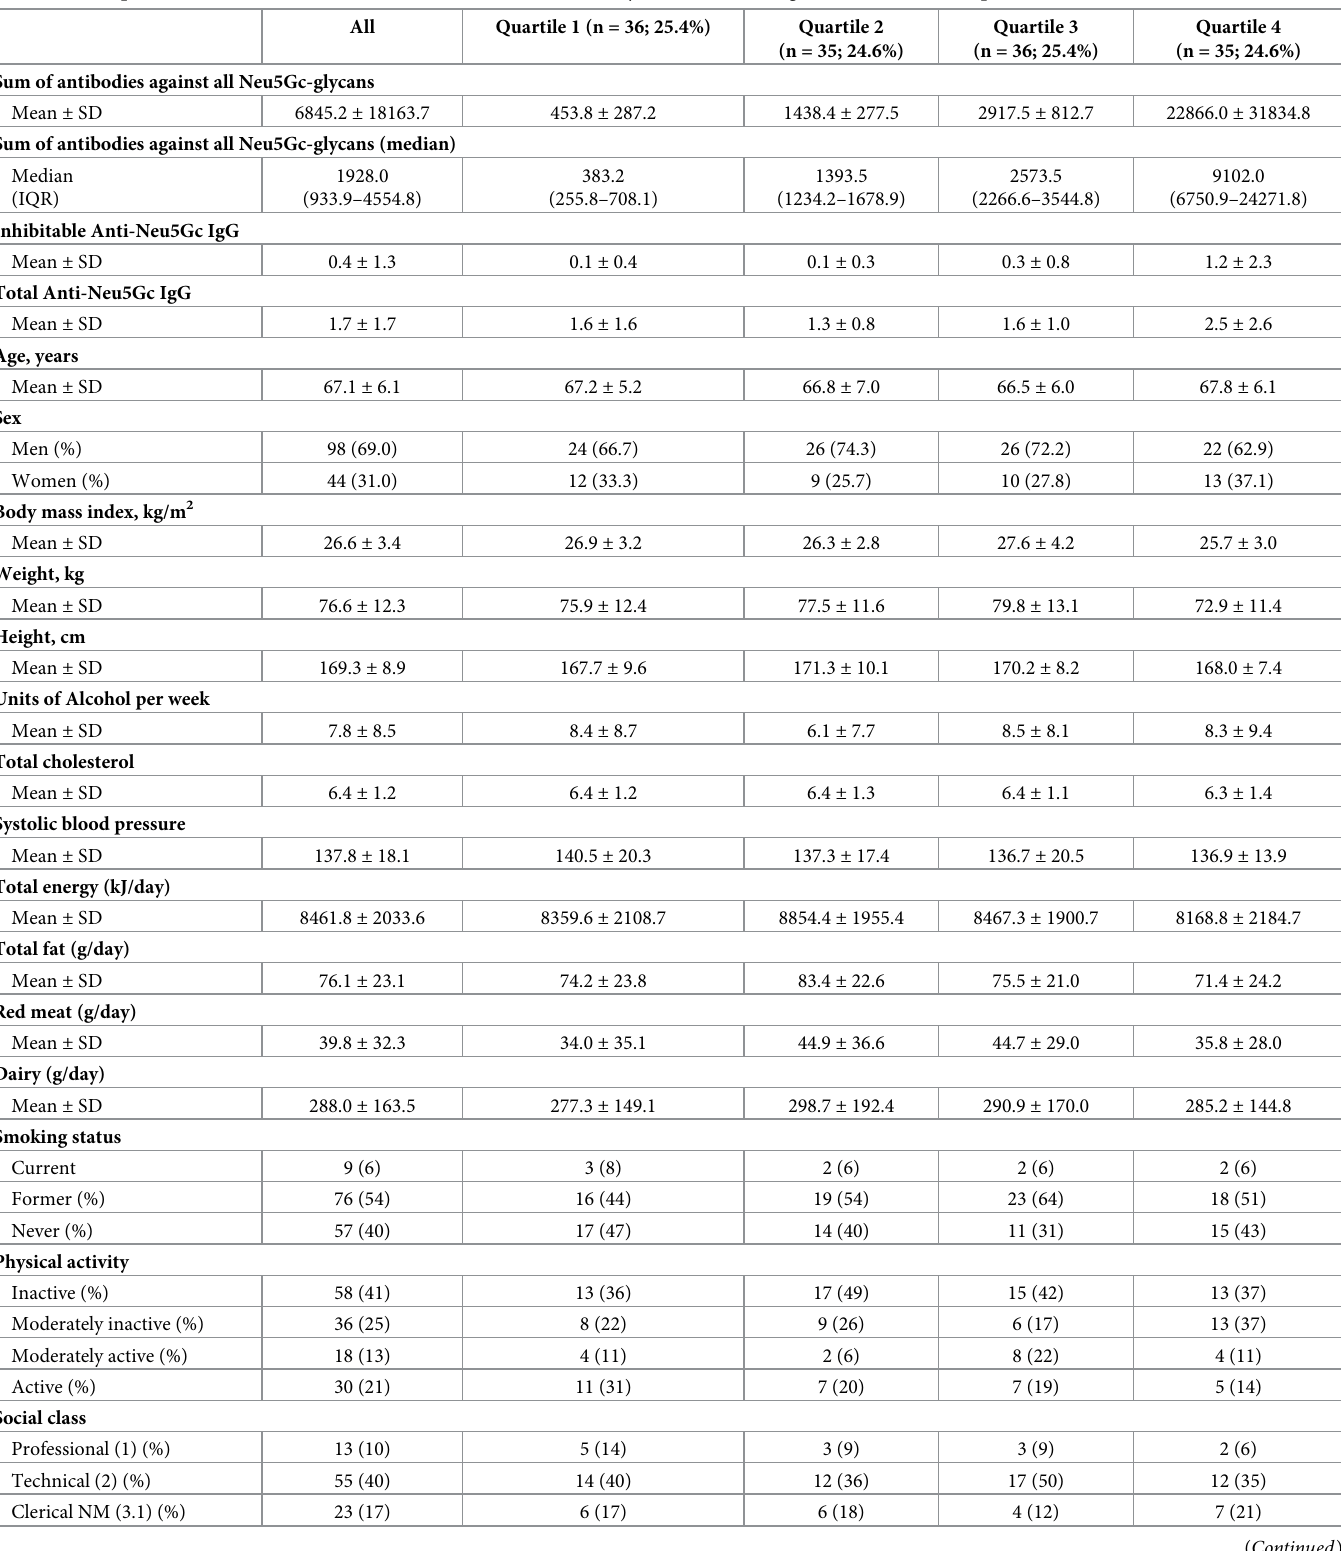
Table 5. Descriptive characteristics of the colorectal cancer case-control study for anti-Neu5Gc IgG levels, divided into quartiles in the EPIC-Norfolk cohort.